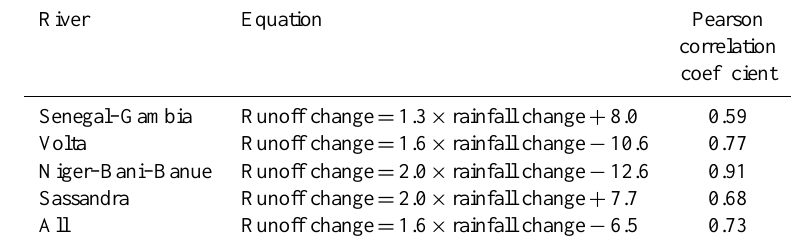
Table 3. Regression equation between rainfall change and runoff change, for each of the river.